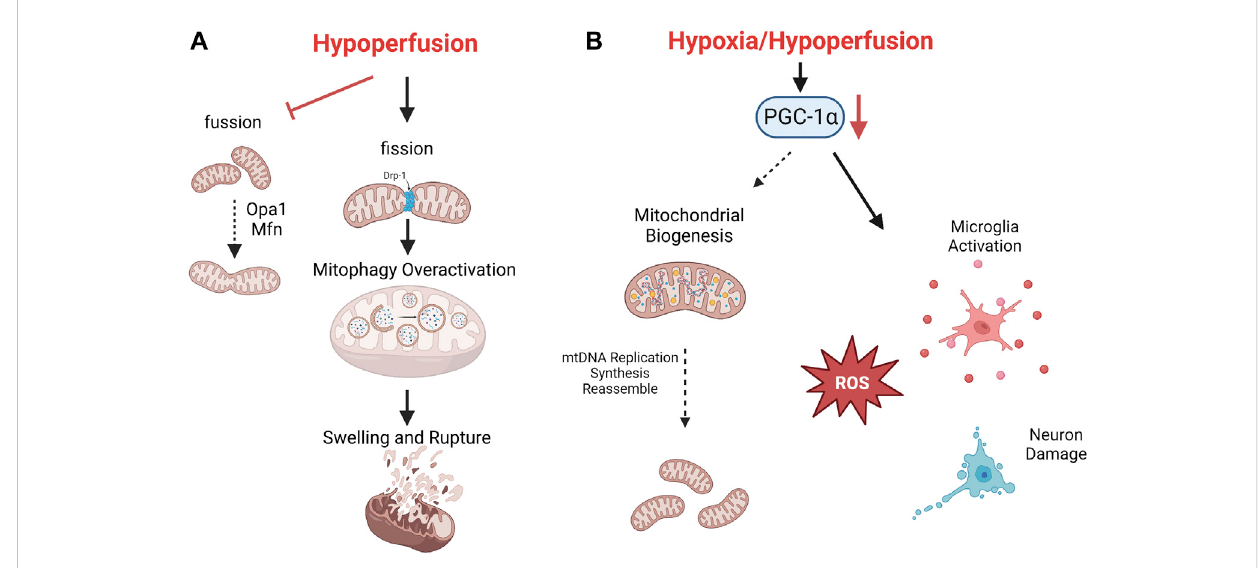
FIGURE 2 The mechanism of mitochondrial autoregulation disorder after CCH. Consistent hypoperfusion seriously damages mitochondrial dynamics. Mitochondrial fi ssionisaggravatedandcausesoveractivationofmitophagy,which fi nallyleadstoswellingandrupture (A) .LowlevelofPGC-1 α afterCCH promotes oxidative stress, microglia activation and neuron death (B)